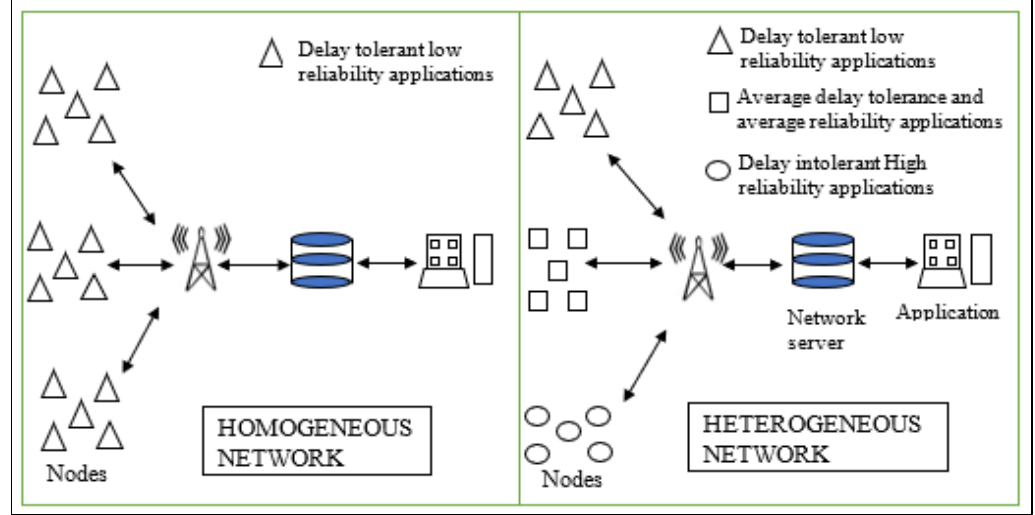
Figure 2: Homogeneous and Heterogeneous LoRaWAN